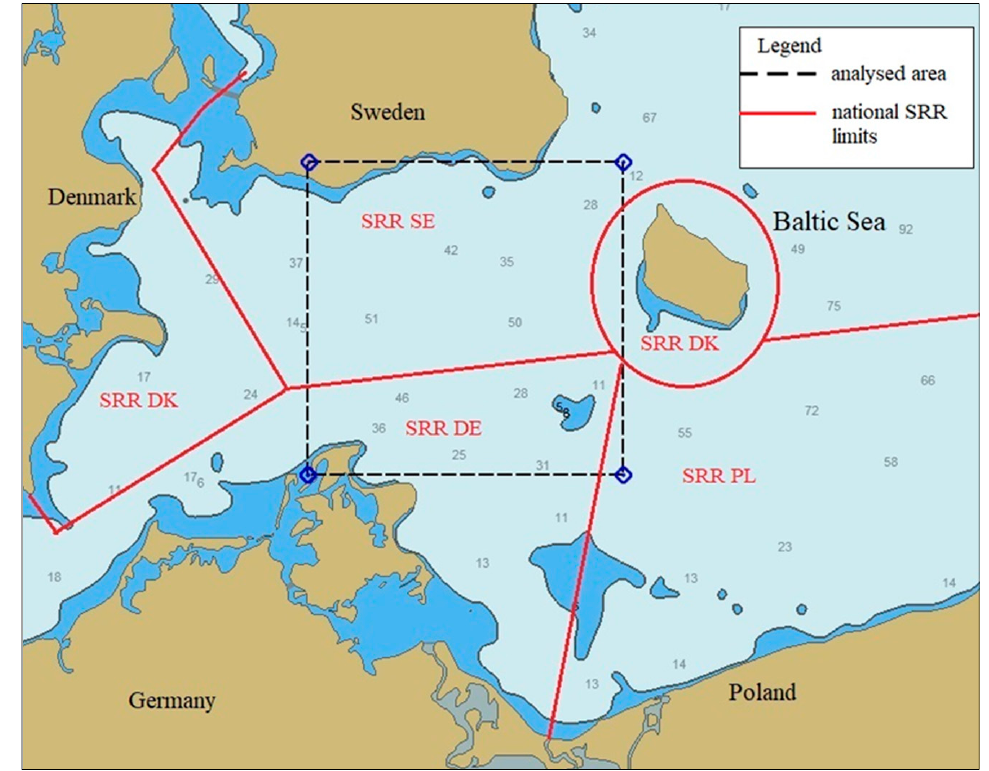
Figure 3. Area under analysis (authors’ own work).